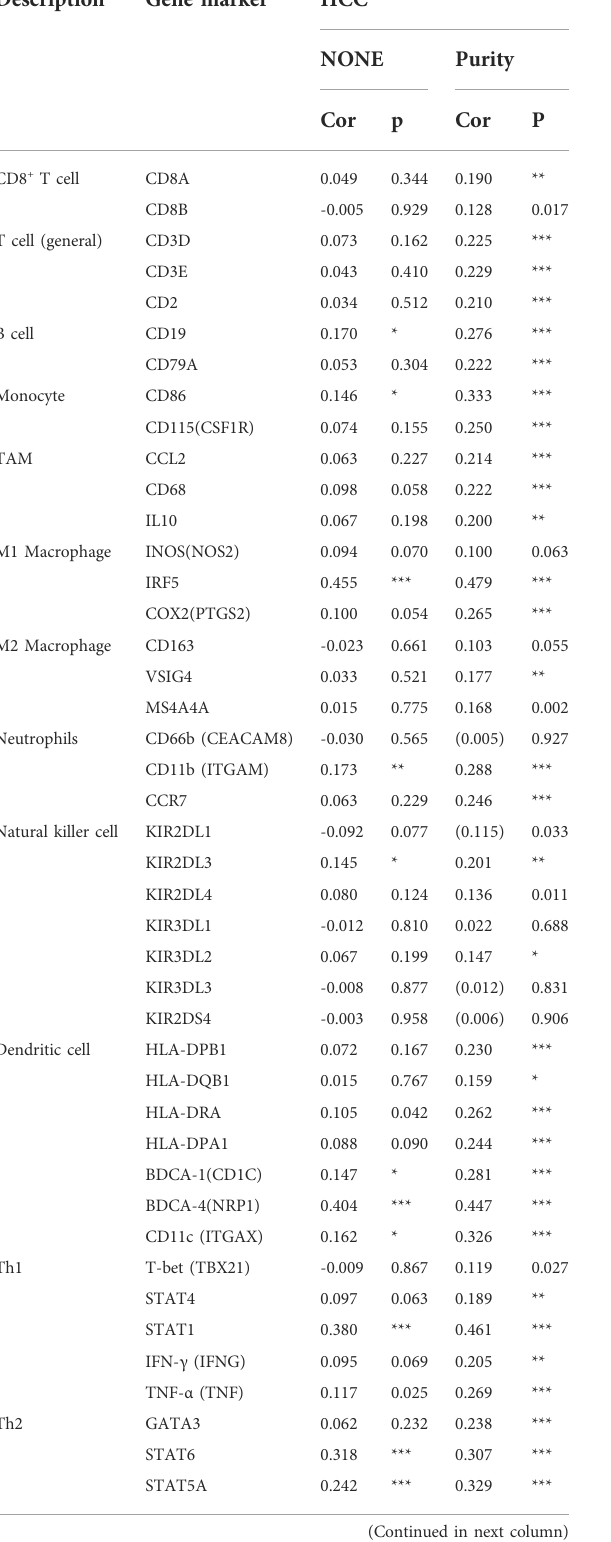
TABLE 2 Correlation analysis between PIGC and relate genes and markers of immune cells in TIMER. Description